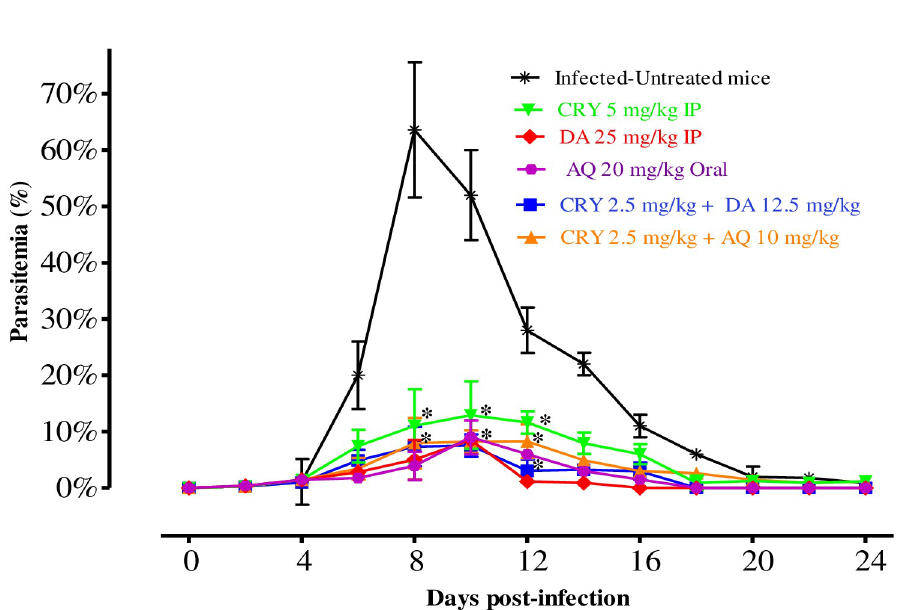
Fig 3. The growth inhibition of CRY on B . microti in vivo . The inhibitory effects of DA-i.p., AQ-oral, and CRY-i.p. single treatments and combination treatments of CRY with DA and AQ as compared with the untreated group. The asterisks ( � ) indicate statistical significance ( P < 0.05) between treated and untreated mice. The arrow indicates 5 consecutive days of treatment. Parasitemia was calculated by counting infected RBCs among 5000 RBCs using Giemsa- stained thin blood